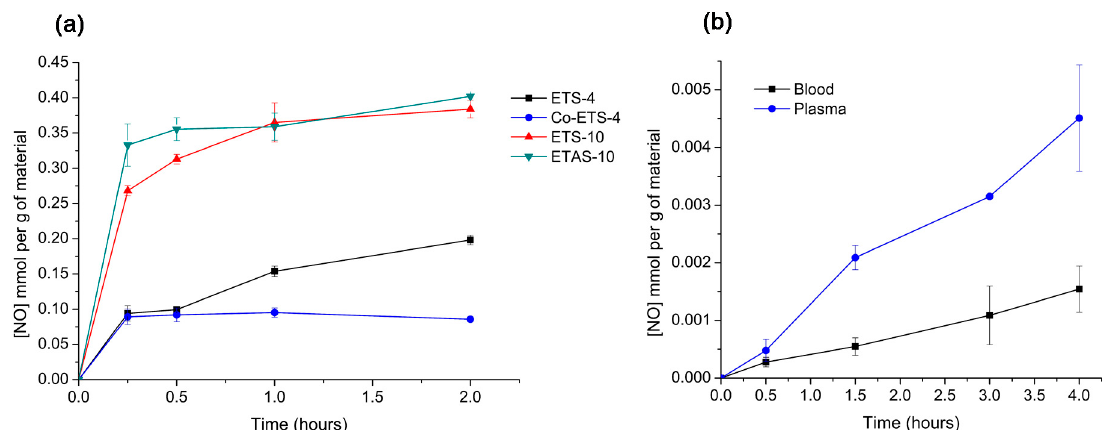
Figure 4. Nitric oxide release kinetics obtained using an indirect measurement through nitrite quantification by Griess assay. ( a ) Release profiles of ETS-4, ETAS-10 and modified specimens at a concentration of 450 µg mL − 1 in supplemented RPMI-1640 medium at 37 °C [5]. ( b ) Release profiles of Zeolite-4A (11.7 mg mL − 1 ) obtained in different biological media (human blood and plasma) at room temperature. n = 3; mean ± standard deviation shown.